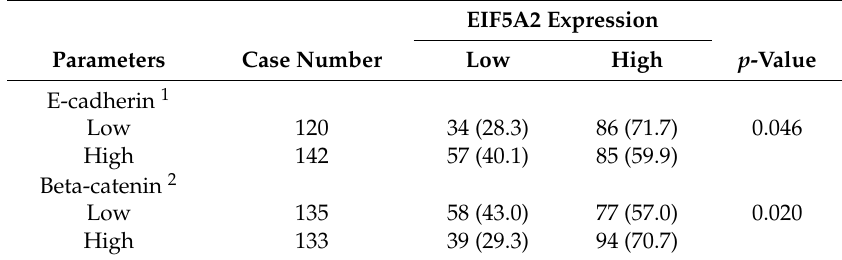
Table 2. Relationships between EIF5A2 expression and epithelial–mesenchymal transition markers in oral cancer